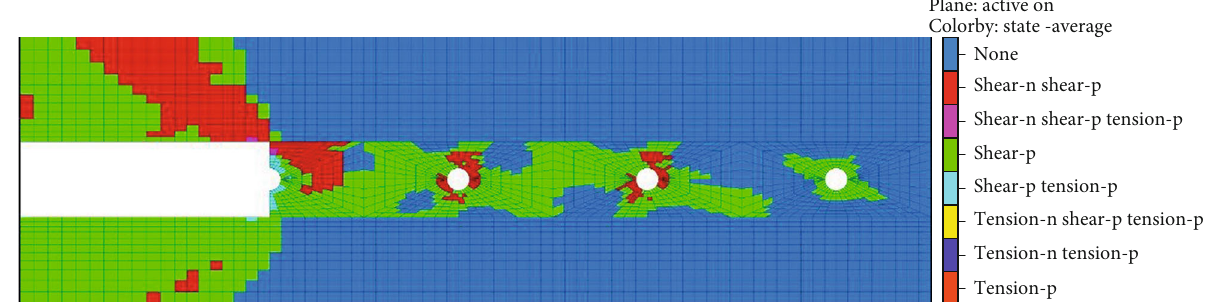
Figure 9: Plastic zone changes in surrounding rock of large-diameter boreholes.